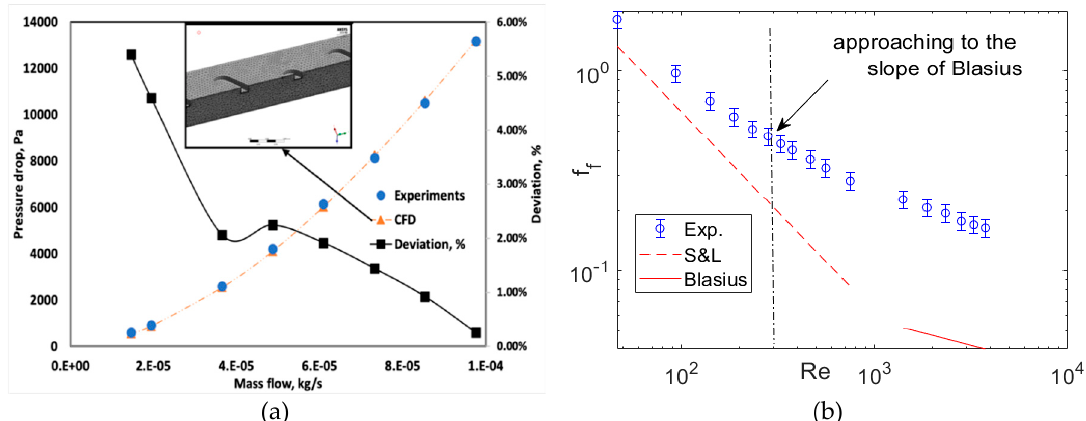
Figure 9. Experimental and CFD pressure-loss comparison and deviations (%) of the CFD results from the experimental pressure losses (dashed lines are for the numerical results and symbols are for the experimental readings) ( a ); experimental friction factor ( b ).